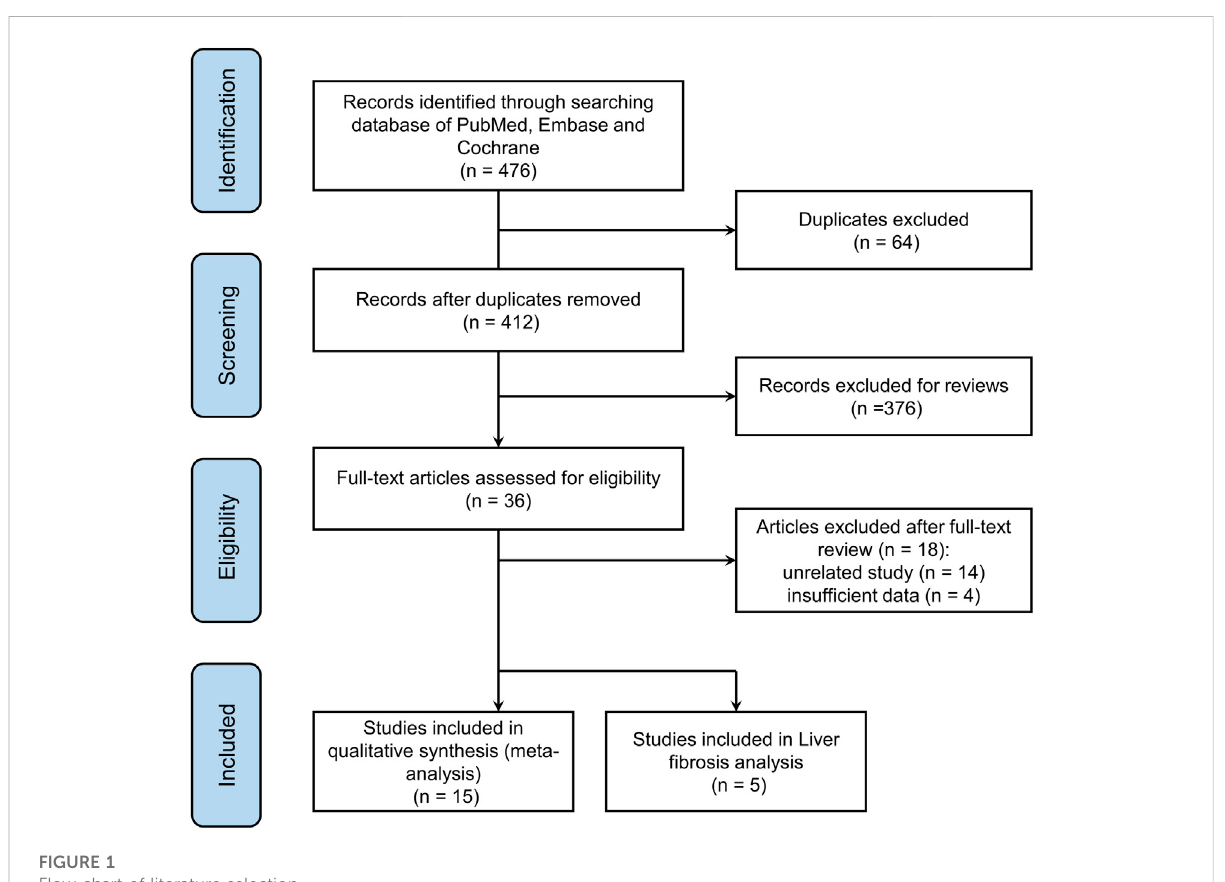
FIGURE 1 Flow chart of literature